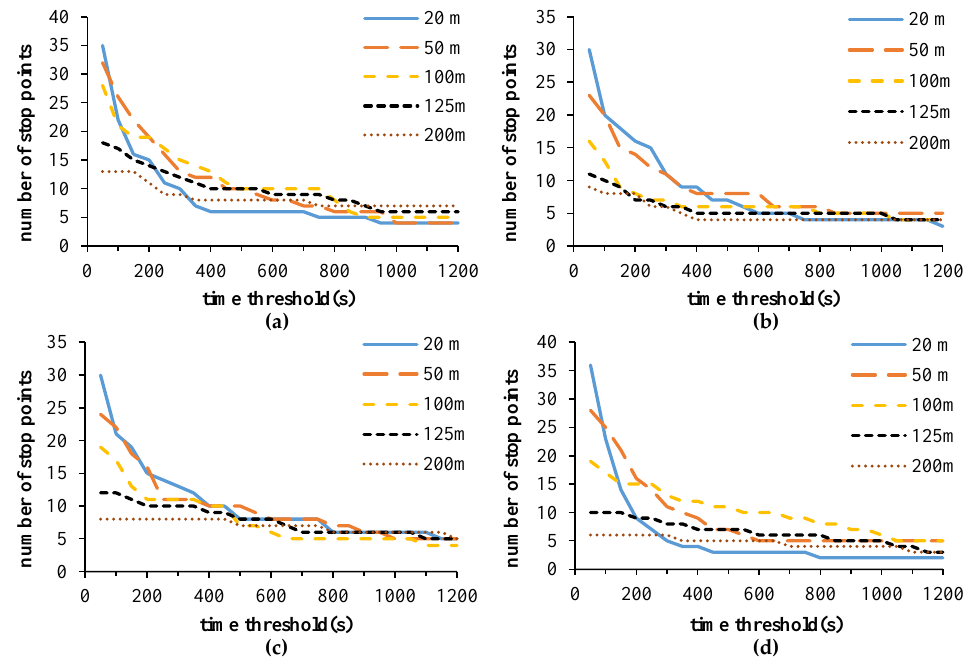
Figure 6. The number of stop points found for different distance and time thresholds. ( a ) The results of volunteer A; ( b ) Volunteer B; ( c ) Volunteer C; ( d ) Volunteer D.